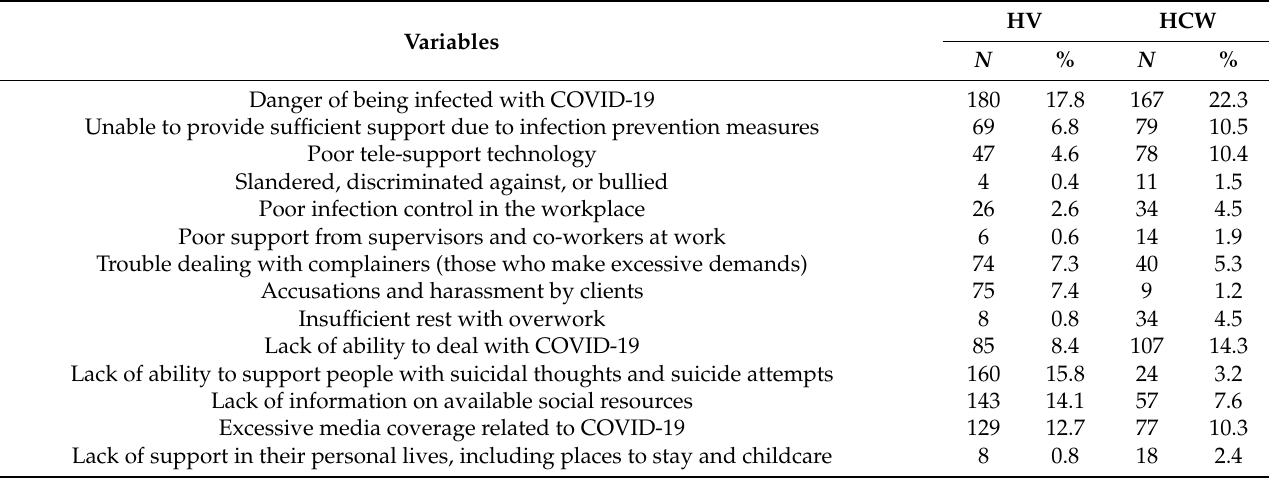
Table 2. Stress and Anxiety When Providing Care for Suicidal Individuals During the COVID-19 Pandemic ( n = 818).